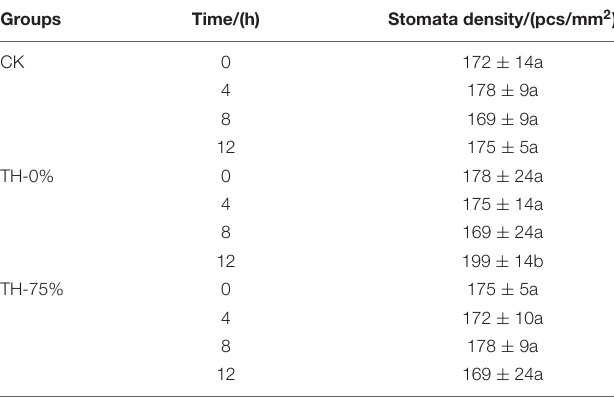
TABLE 2 | The stomatal density of leaf surfaces in CK, TH-0%, and TH-75% at 0, 4, 8, and 12 h. Groups Time/(h) Stomata density/(pcs/mm 2 )